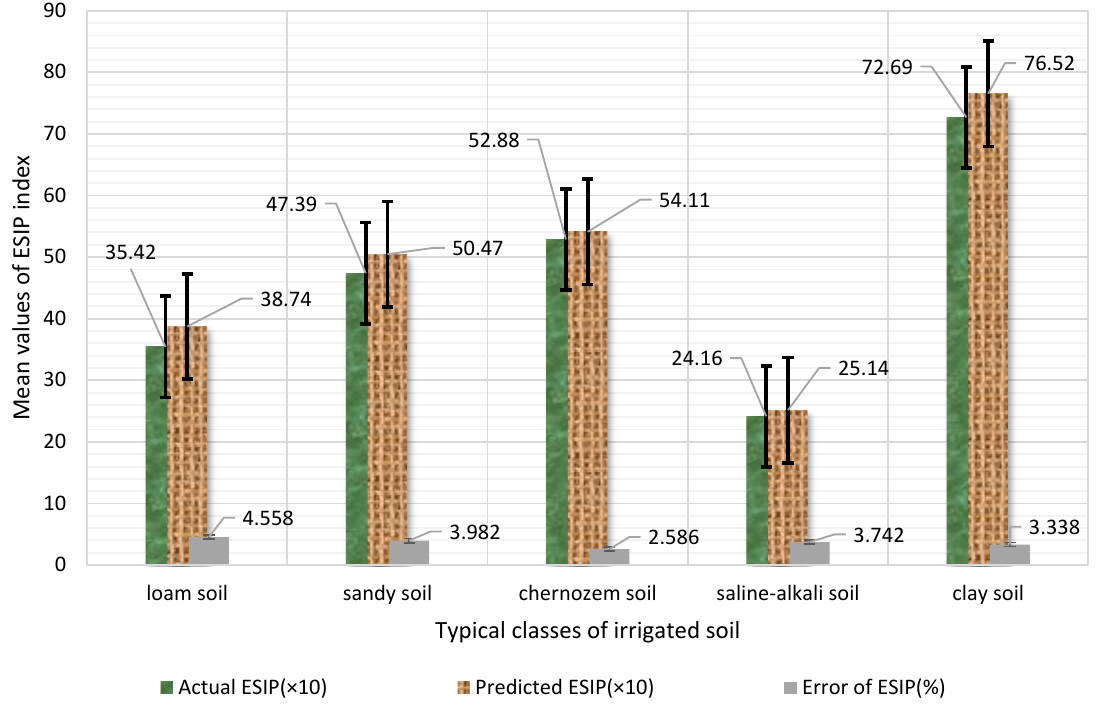
Figure 16. Comparison between the actual and predicted ESIP values in typical soil types.